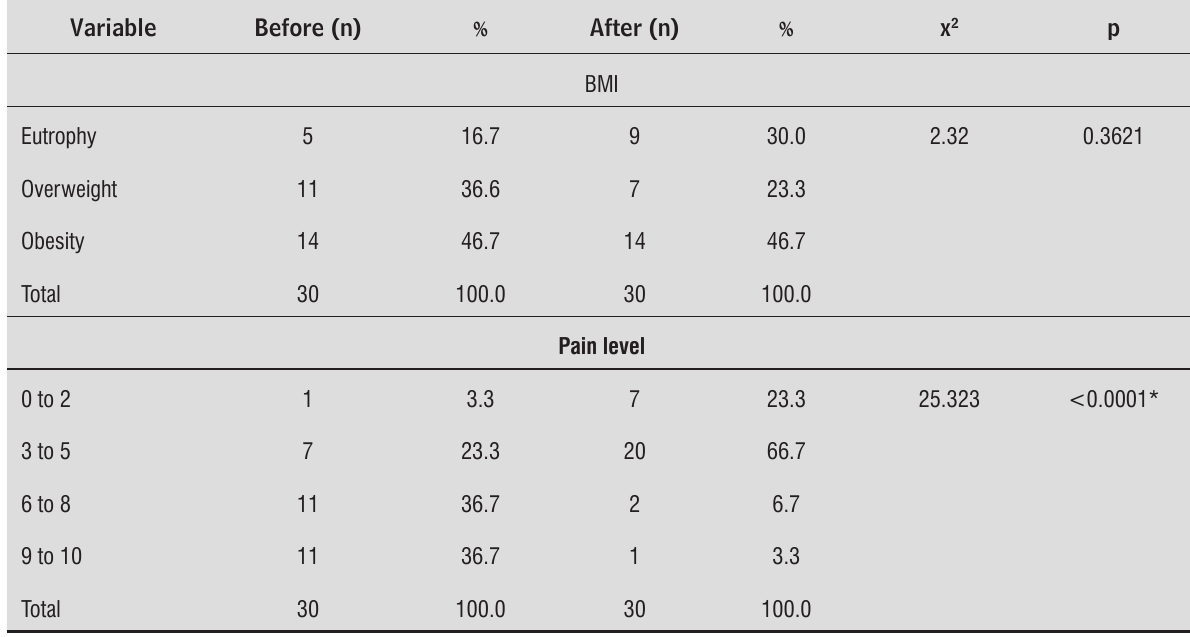
Table 1 - Comparison of ordinal variables BMI and Pain before and after treatment of kinesiotherapy and electrothermo- therapy São Luís, MA, 2009